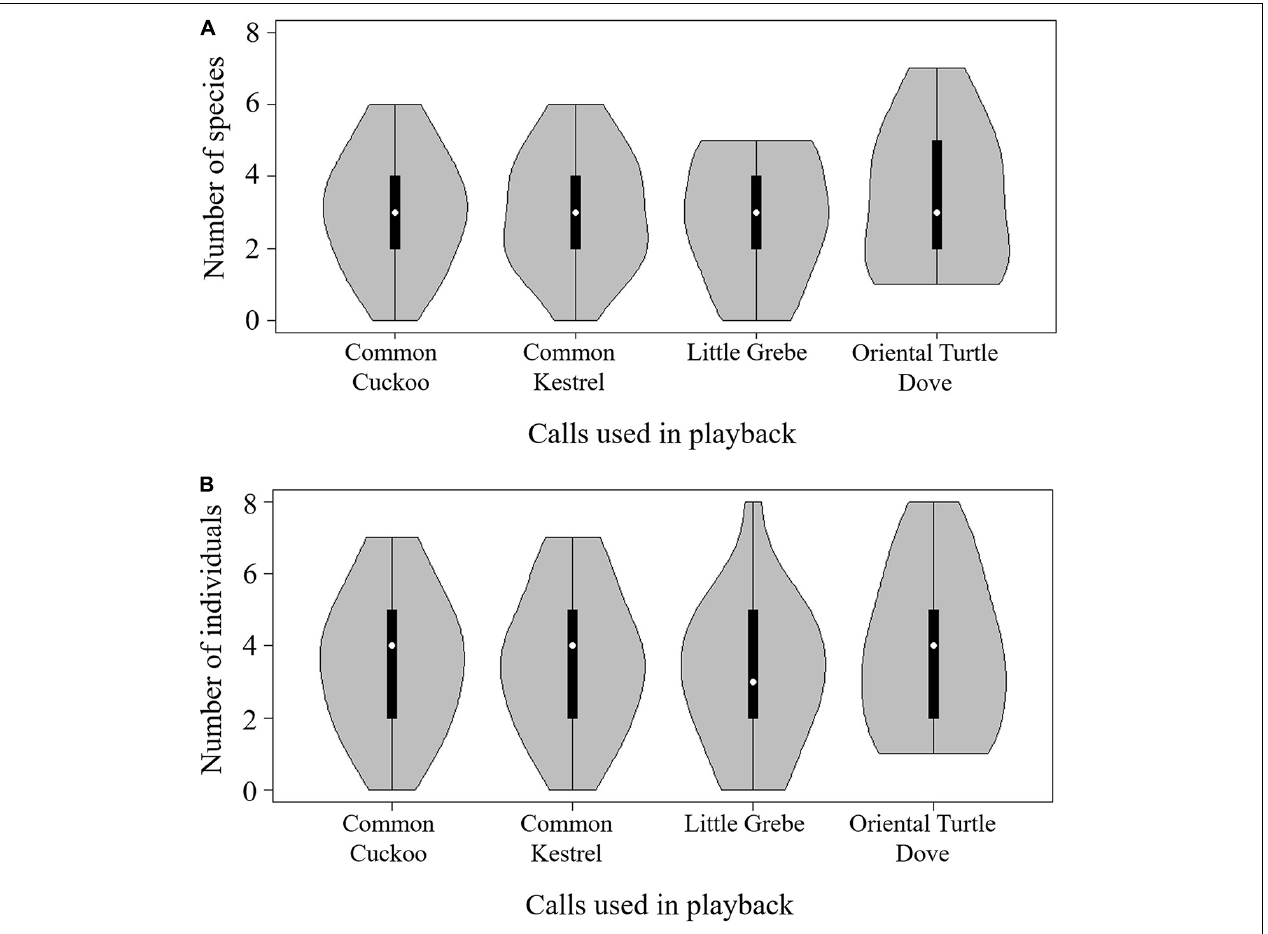
FIGURE 5 | Number of species (A) and individuals (B) heard after playback. Sample sizes for each group is 25. In the middle of each density curve is a box plot, with black rectangle showing the ends of the first and third quartiles and white dot the